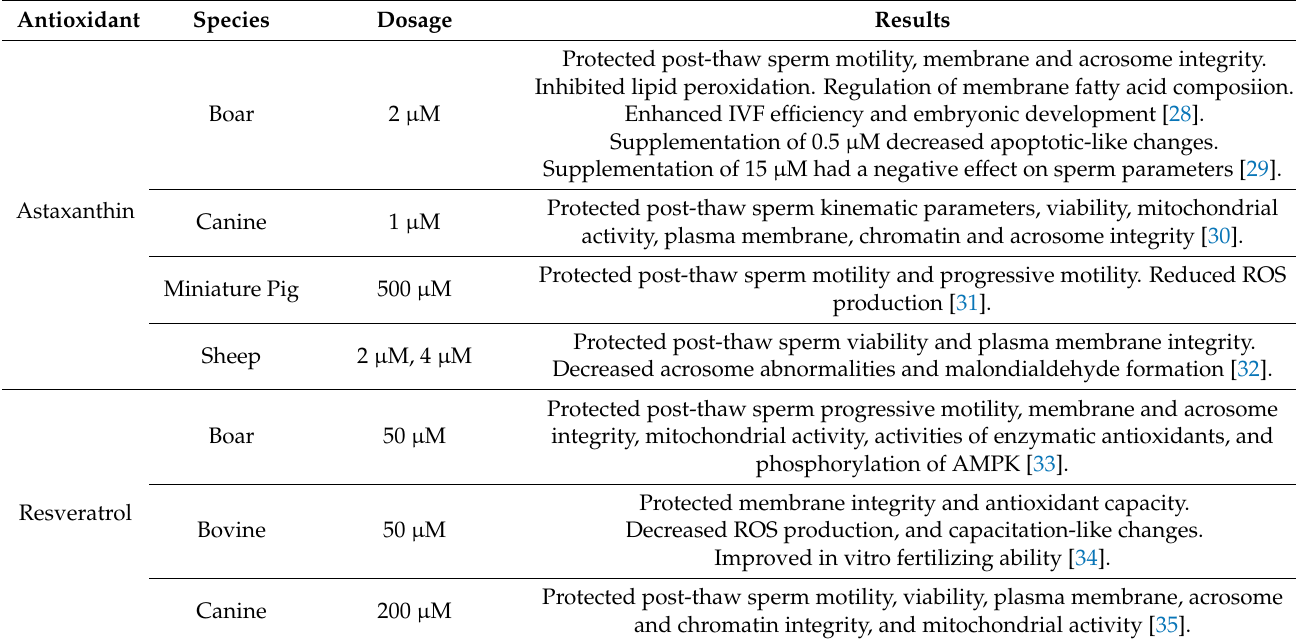
Table 1. List of antioxidants used for sperm cryopreservation in dogs and their effects in different species. Antioxidant Species